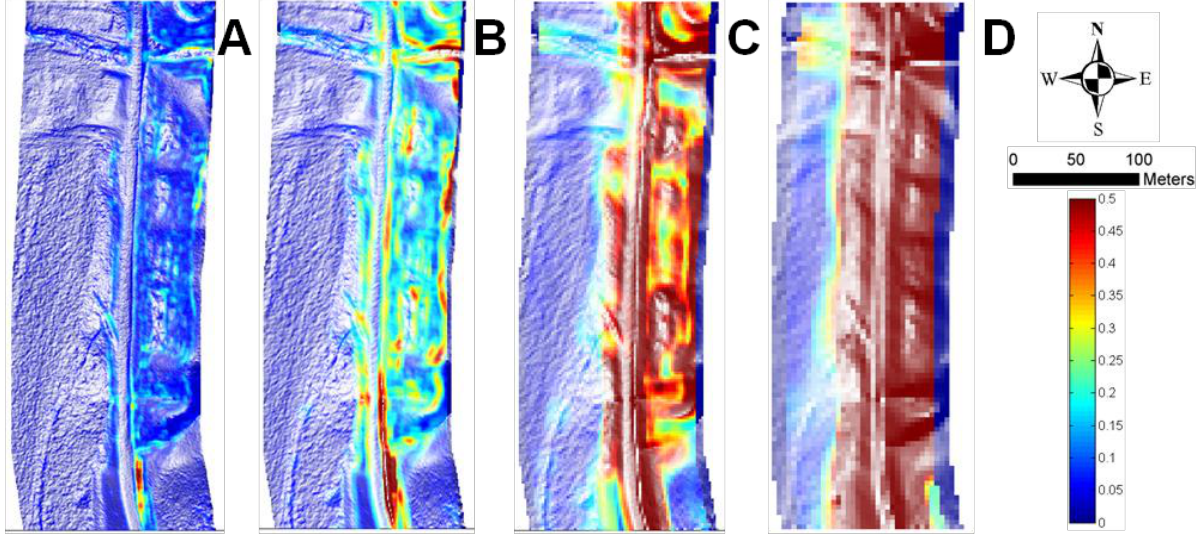
Figure 3. Surface roughness maps with 50 (A), 100 (B), 200 (C), and 400 (D) cm spatial